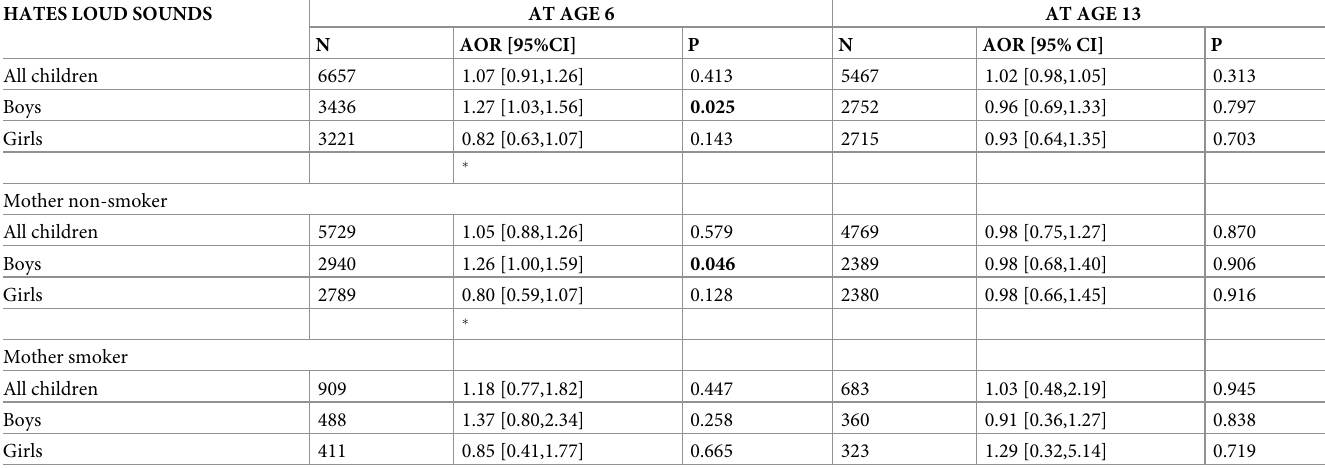
Table 3. Adjusted risk of the child hating loud sounds at ages 6 and 13 if the maternal grandmother had smoked in pregnancy. [P values < 0.10 are in bold]. Adjusted for year of birth of each grandparent, age of grandfather at birth of the mother, ethnic origins of both grandparents. HATES LOUD SOUNDS